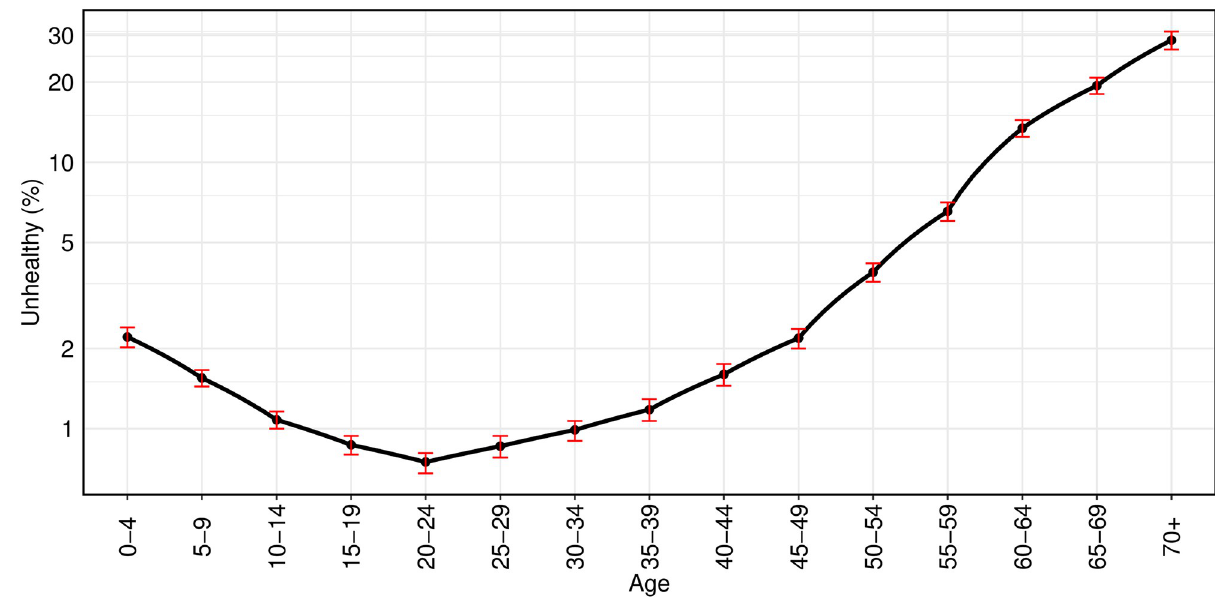
Fig 2. Age specific unhealthy